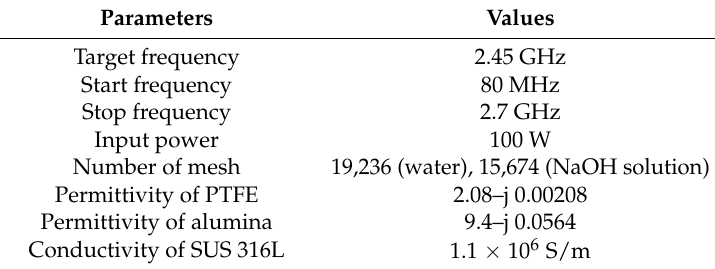
Figure 2. Simulation model of the cylindrical applicator with the microwave irradiation probe. Table 1. Simulation parameters.